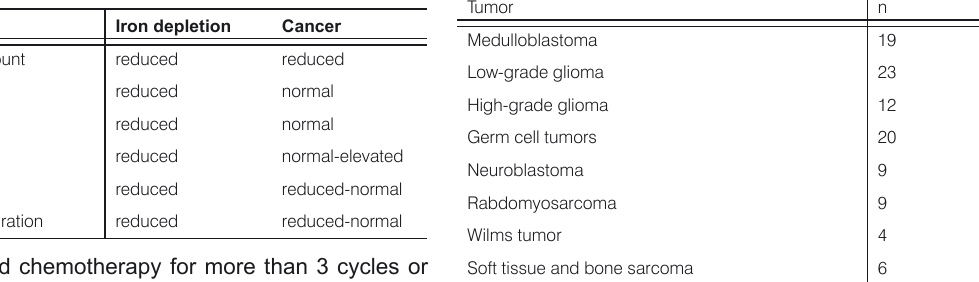
Table 1. Differential diagnosis of iron depletion or cancer related anemia.